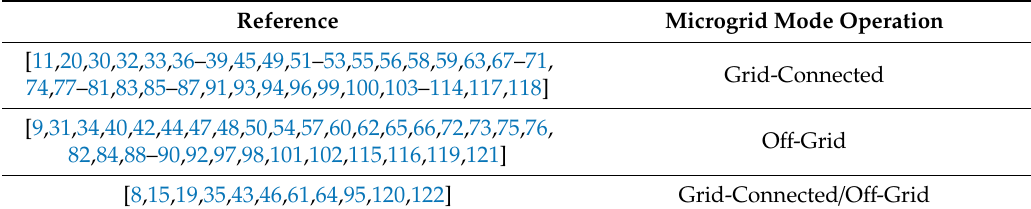
Table 4. Microgrid operating modes.